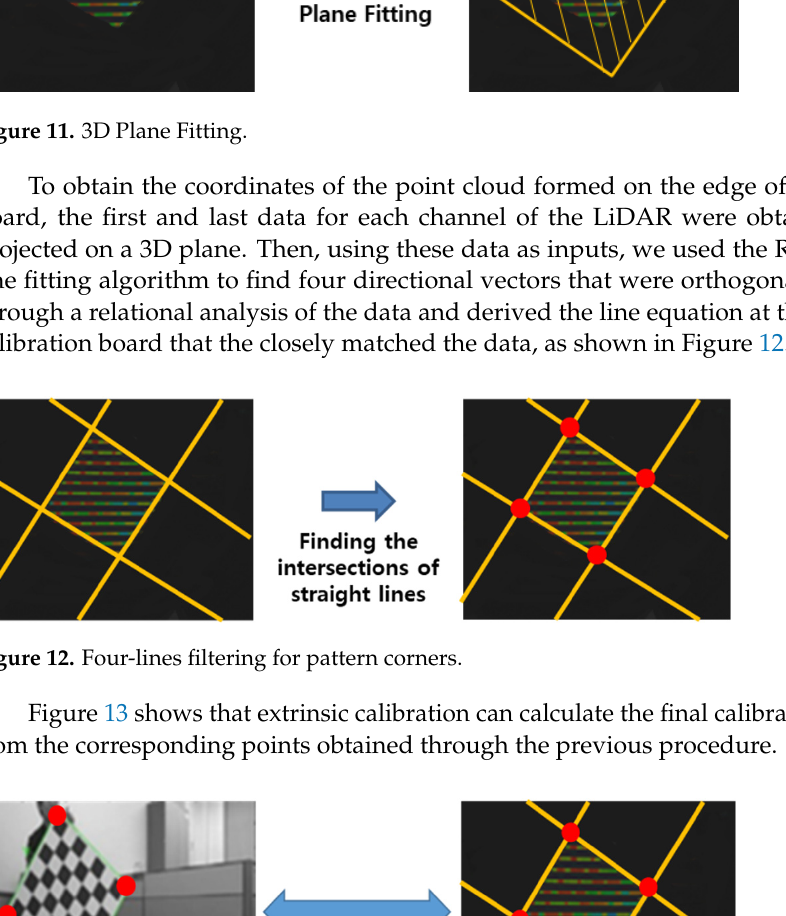
Figure 10. Noise filtering for 3D LiDAR data of interests.